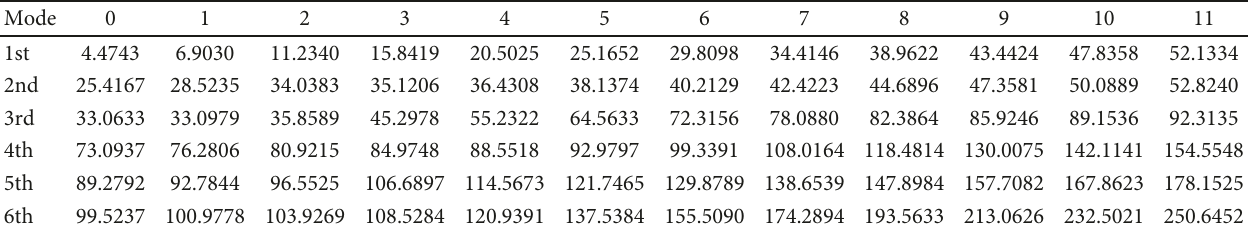
Table 11: Nondimensional frequency parameters for the fi rst six modes of the FG sandwich blade with varying nondimensional rotation velocities ( l = 3 , h = 20 , n = 2 , h = 1/2 , θ = 30 ° , r = 1 , and φ = 45 ° l